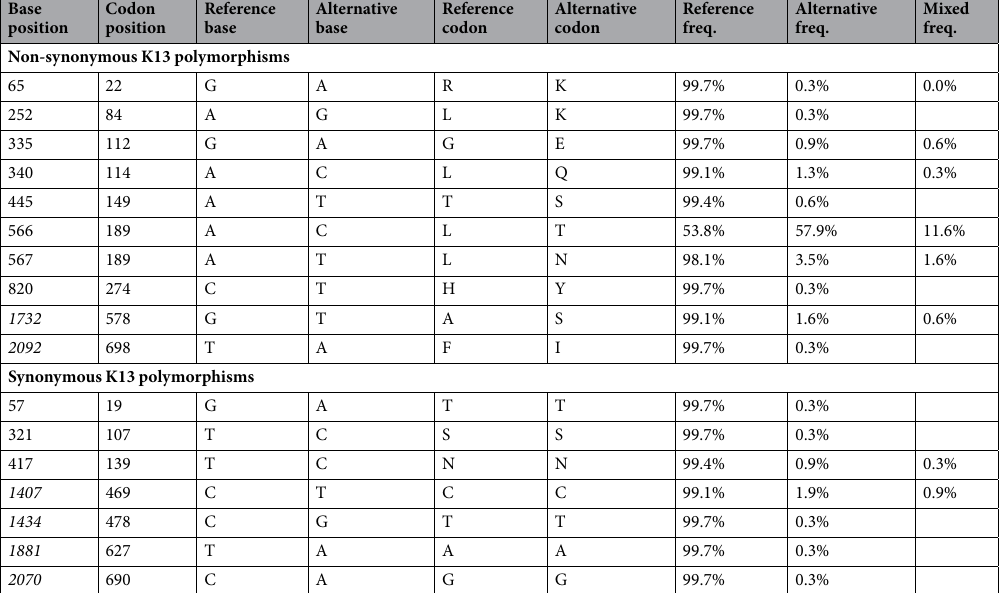
Table 4. Polymorphisms in pfK13 . The table describes the various polymorphisms found in pfK13 for the 318 resistance-profiled samples, and the frequencies in which the reference and alternative base were found, as well as the frequencies of mixed infections. SNP positions written in italic indicate that they are located in the propeller region of pfK13 . Note that mixed infections were counted in both the reference and alternative frequencies.